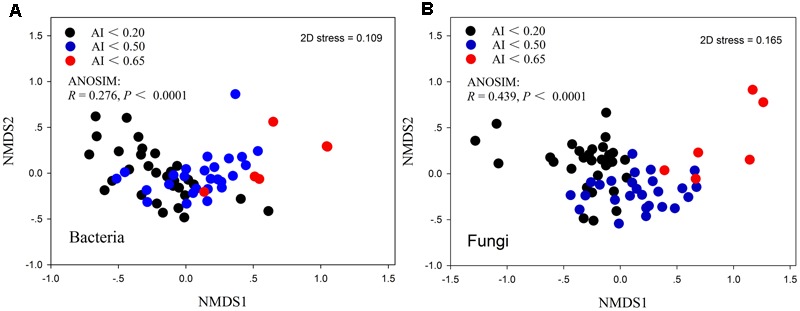
Non-metric multidimensional scaling (NMDS) ordination of the bacterial community (A) and fungal community (B) compositions from 62 samples.